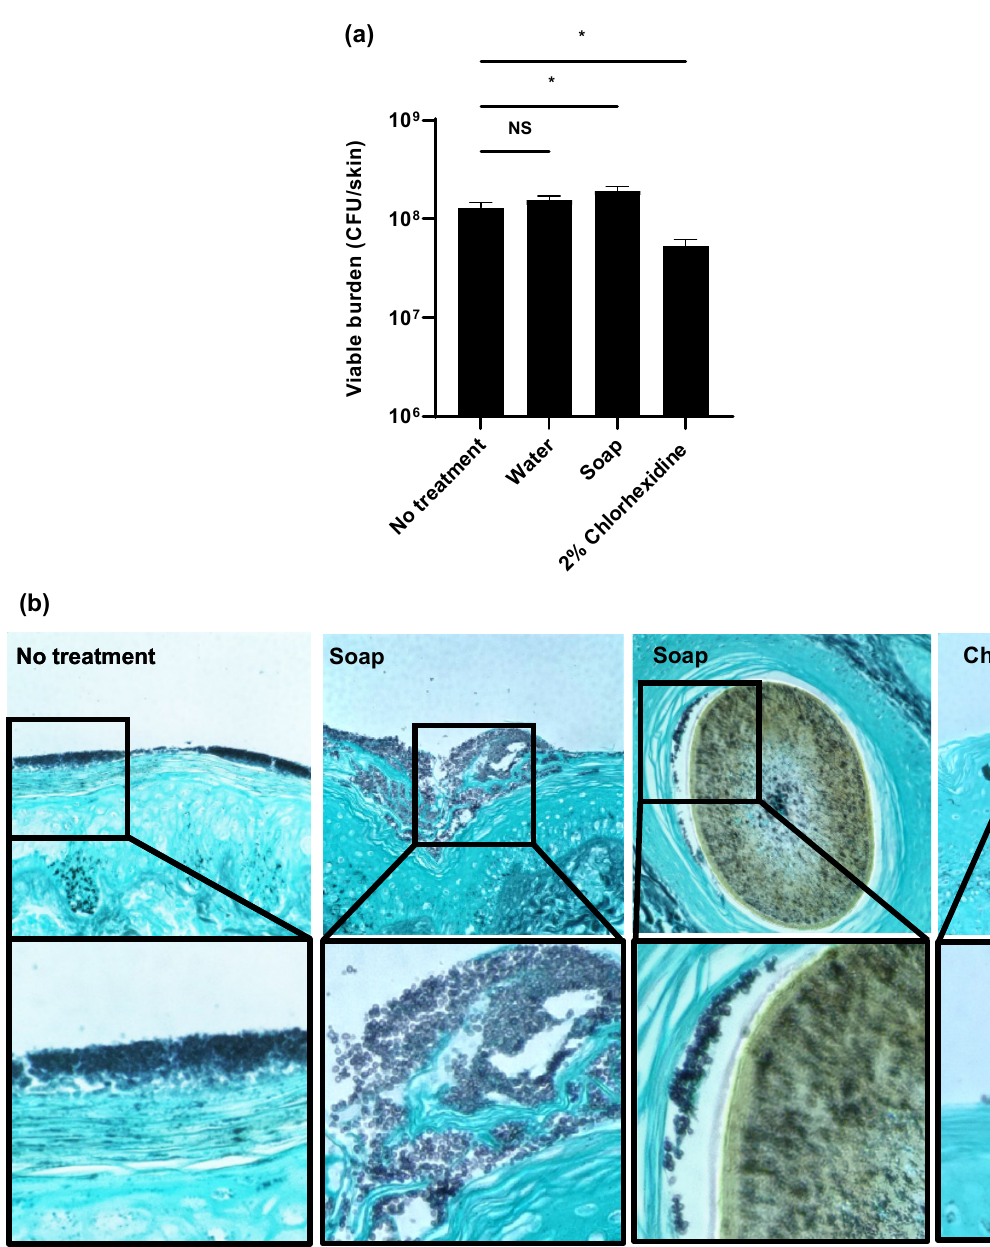
Figure 1. Impact of biocides on C. auris colonization of porcine skin: ( a , b ) C. auris was applied to the surface of full-thickness porcine skin samples and samples were incubated for 24 h to allow for colonization. Water, soap (with 0.3% chloroxylenol), or 2% chlorhexidine gluconate were applied for 1 h daily for 3 days. The impact on colonization was assessed by viable burden ( a ) and histopathology with Grocott’s methenamine silver staining ( b ). With this stain, fungal elements appear dark purple and the hair is brown. Data were analyzed by one-way ANOVA with Holm–Sidak multiple comparison to the control, * p < 0.05, NS = not significant, standard error of the mean shown, n = 3.